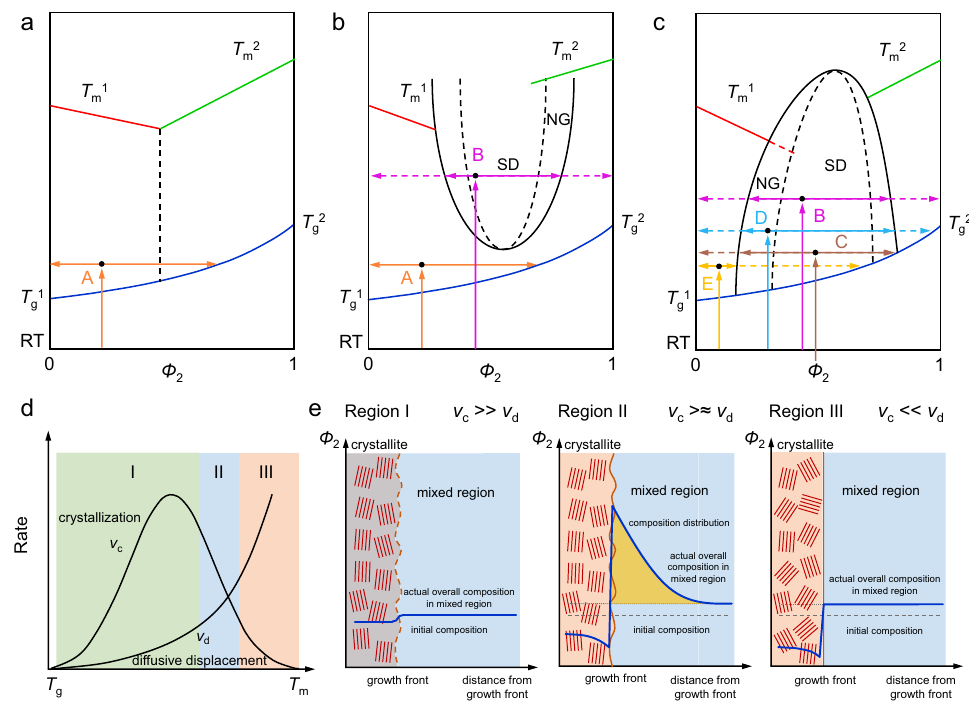
Fig. 5 Schematic thermodynamics and kinetics pathways under different thermal stress. a – c Schematic non-equilibrium phase diagrams of two crystallizable components with a pseudo-eutectic feature, b lower critical solution temperature (LCST) feature, and c upper critical solution temperature (UCST) feature. The capitals A to E and corresponding colored line with arrows represent fi ve possible phase transition routes. Melting point line are denoted by red line ( T m 1 ) and green line ( T m 2 ). Glass transition line is indicated by curves in navy blue. Miscibility gap is surrounded by black solid curve. Inside miscibility gap, black dashed line is used to separate spinodal decomposition (SD) region from nucleation and growth (NG) (also called binodal decomposition (BD)) region. d Schematic sketch of crystallization ( v c ) and diffusive displacement ( v d ) dependence on temperature between glass transition temperature ( T g ), and melting temperature ( T m ). e Composition pro fi les at growth front of three regions indicated in d . Horizontal axis represents the distance from the growth front (indicated by orange curve). Vertical axis represents the content of component (denoted as Φ 2 ) with higher T g or simply amorphous. Composition distribution is indicated by solid blue curve, whereas initial composition and actual overall composition in mixed region are indicated by dash gray line and dot gray line,